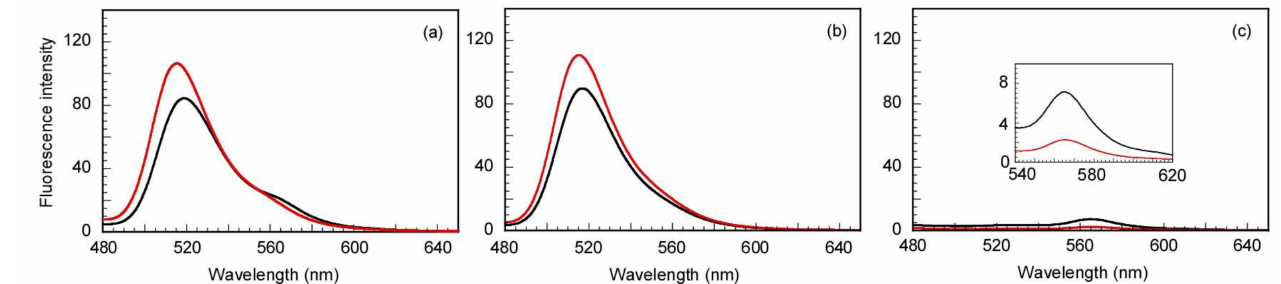
Figure 7. Fluorescence spectra of A488-labeled block and A555-labeled random copolymers ( a ), A488- labeled block copolymer ( b ), and A555-labeled random copolymer ( c ) in mixtures with nonlabeled random and block copolymers at a total polymer concentration of 10.0 g/L in water at pH 2 (black) and 11 (red). λ ex = 450 nm, the excitation and emission slit widths were 20 and 2.5 nm, respectively. A488 = Alexa Fluor 488 C5 maleimide; A555 = Alexa Fluor 555 C2